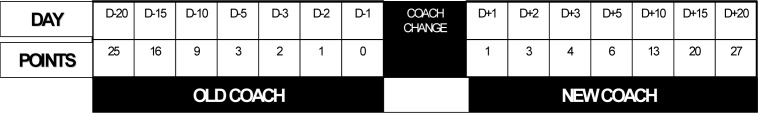
Comparison between the points gained by the old coach and the new coach in several periods prior and following to date of turnover